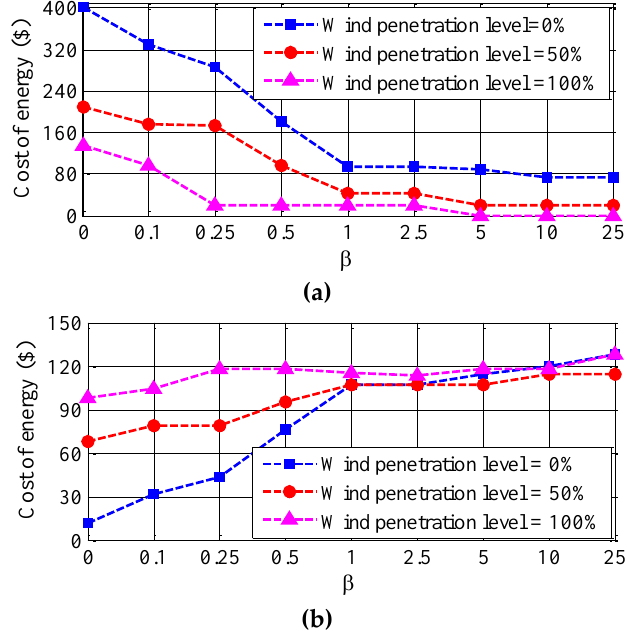
Figure 7. Cost of trading energy versus risk aversion parameter ( a ) buying from the main grid, ( b ) selling to the main grid.